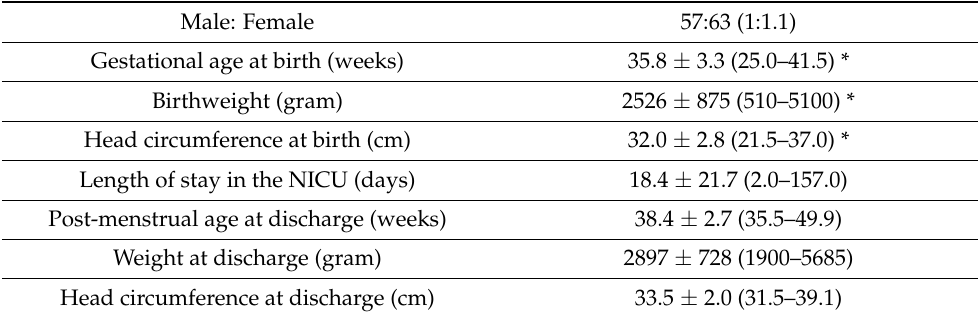
Table 1. Study population demographics ( n = 120). Male: Female 57:63